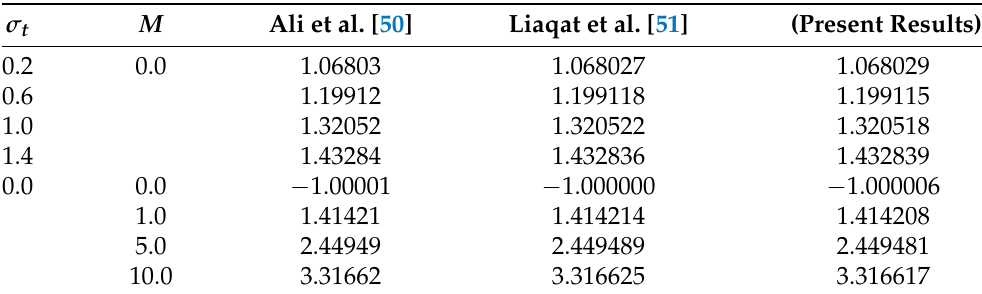
Table 1. A comparison of − f (cid:48)(cid:48) ( 0 ) for various values of σ t and M, when λ = N r = E I = S B = L f = 0 with Refs. [50,51].